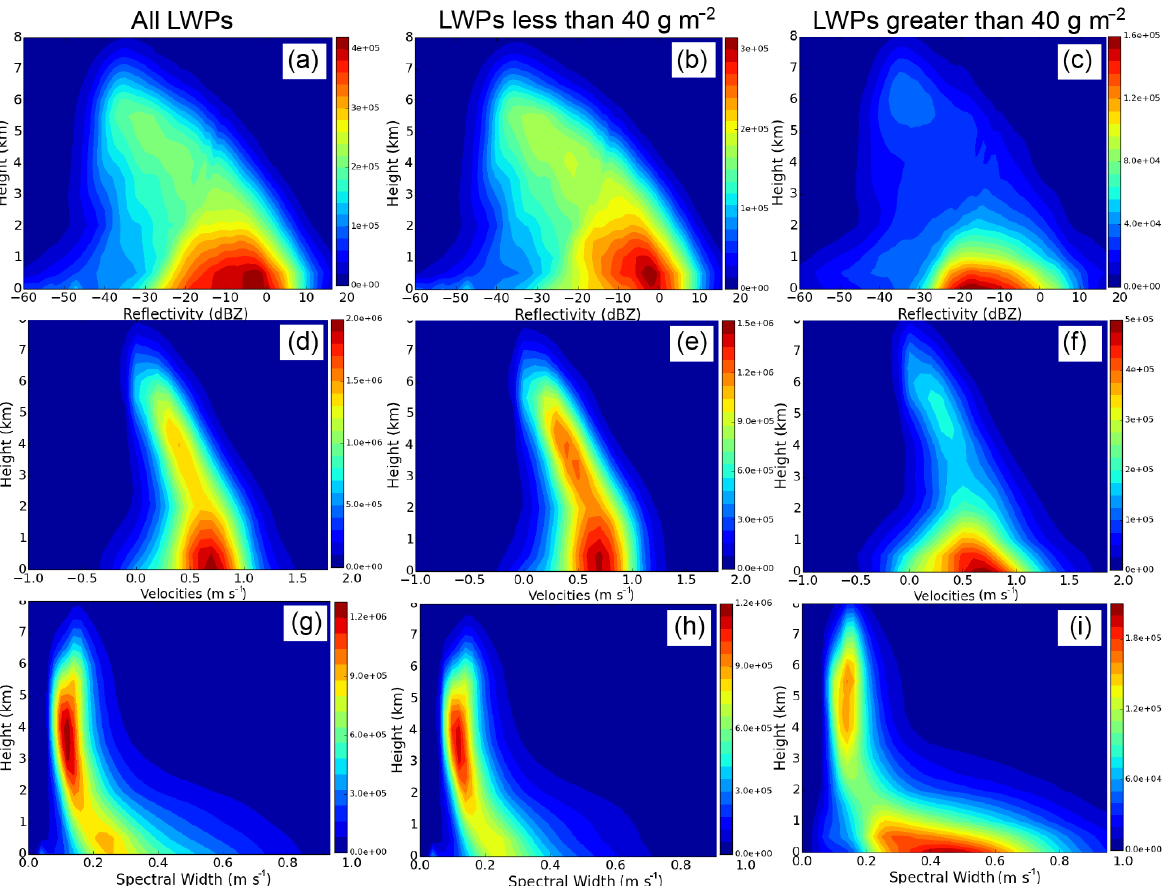
Figure 1. CFADs of MMCR reflectivity for summer (JJA) at Summit, Greenland, from June 2010 to August 2013 with a sample resolution rate every 10s. Panel (a) shows JJA reflectivity for all measured LWPs while panel (b) is filtered to reflectivities only when LWP is less than 40gm − 2 and panel (c) is filtered for cases greater than 40gm − 2 . Additional CFADs of MMCR Doppler velocity and spectral width for summer at Summit, Greenland, for all LWPs (d, g) , when LWP is less than 40gm − 2 (e, h) , and when LWP is greater than 40gm − 2 (f, i) , respectively. LWP less than 40gm − 2 accounted for ∼ 63% of cases, while greater than 40gm − 2 is 22% of cases, and the remaining 15% is clear sky (as determined by the